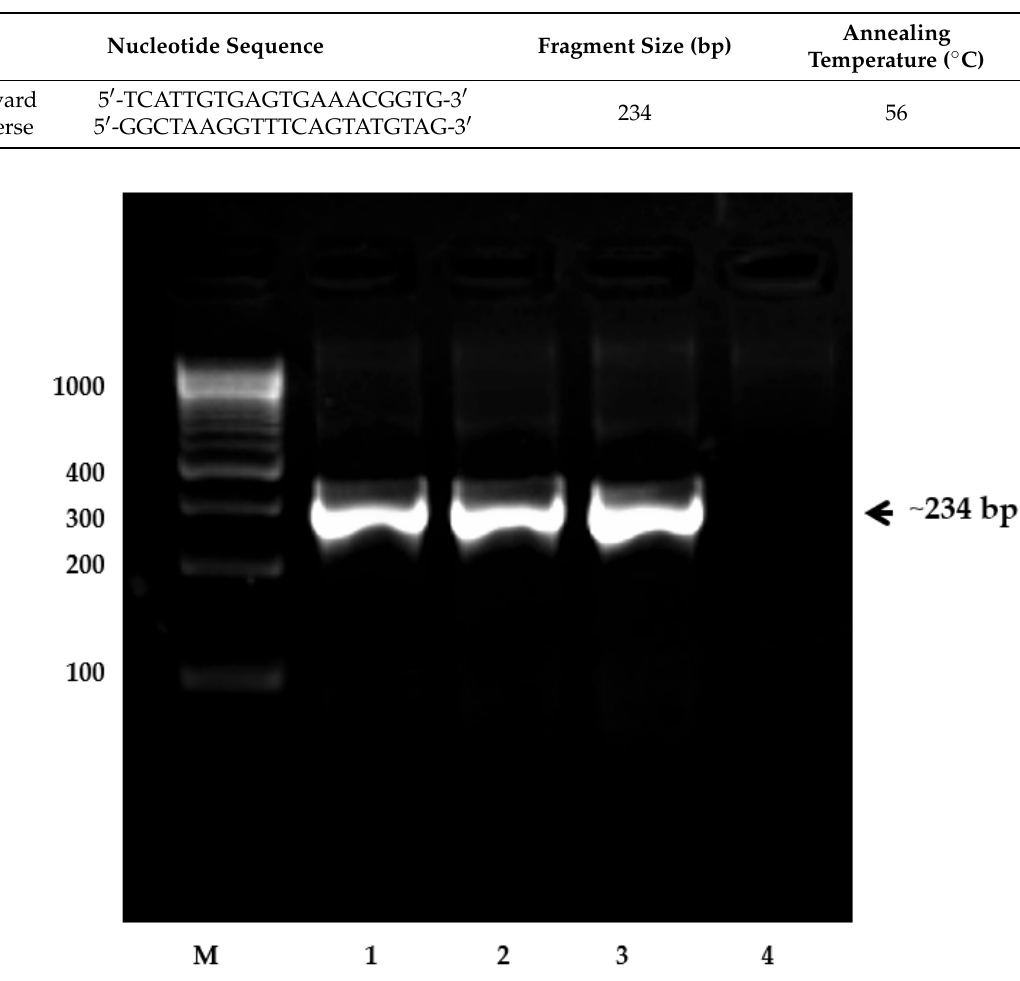
Figure 2. Agarose gel of PCR amplicon for identification of Aphanomyces invadans using ITS1 region primers. Lane 1–3: Positive amplicons of A. invadans ; Lane 4: Vibrio cholera (EMM1) serotype (control). Molecular mass standards (M) 100 bp (DNA ladder) are shown on the left. Positive amplicon with arrow mark (~234 bp) is indication for pathogenic A. invadans identified from 1–3 isolate template DNA.